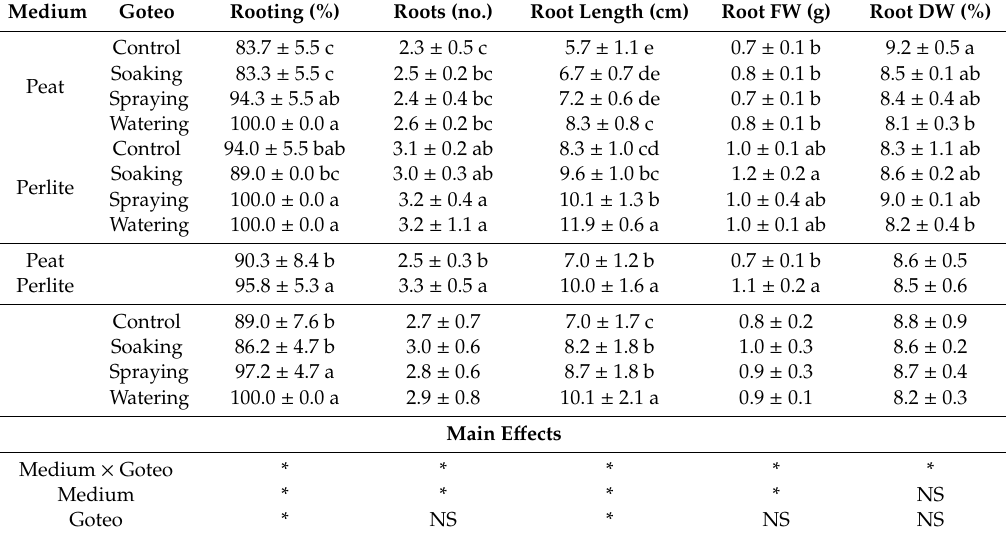
Table 1. E ff ect of medium and biostimulator Goteo on the rooting percentage and root parameters of Pennisetum ‘Vertigo’